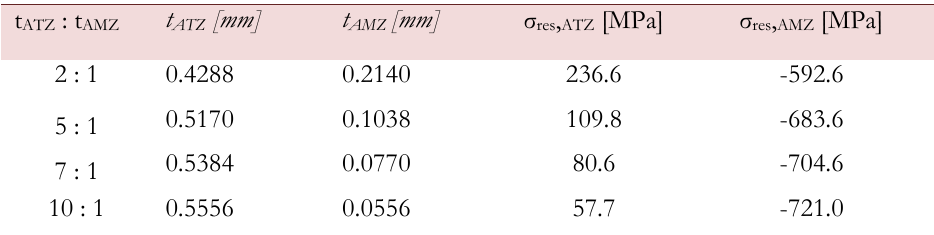
Table 2: Residual stresses calculated for different ratio of layer thicknesses ( t ATZ : t AMZ ) by Eq.